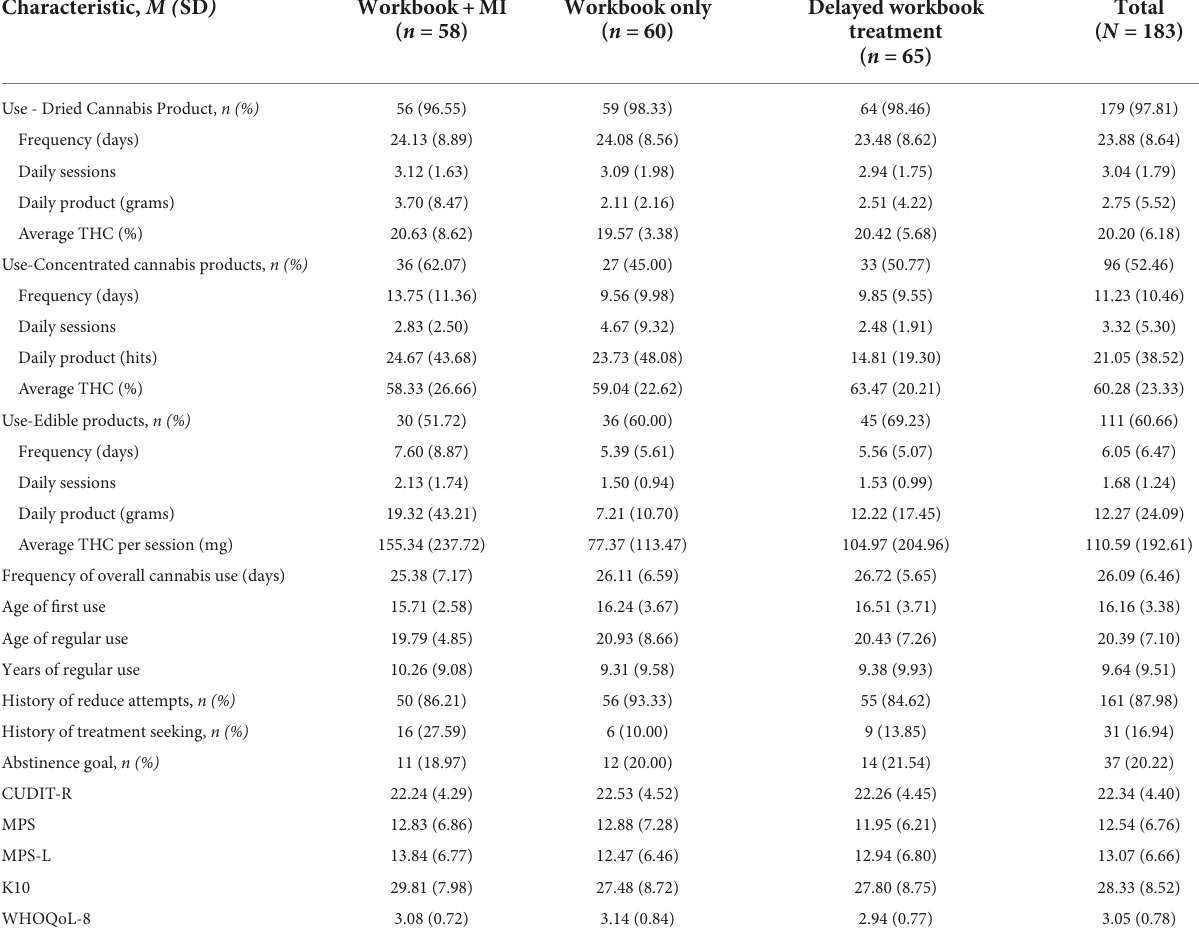
TABLE 3 Cannabis engagement characteristics and scores on external measures at baseline across entire sample.